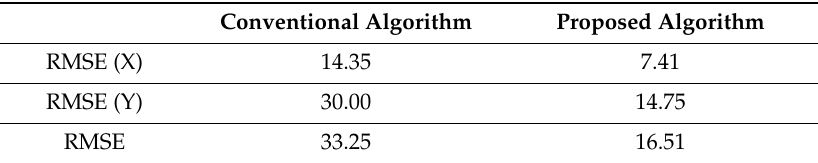
Figure 13. Results of the vehicle trajectory extraction corresponding to the di ff erent algorithms: ( a ) driving straight (up and down); ( b ) driving straight (left and right); ( c ) right turn; and ( d ) left turn. Table 3. Root mean squared error (RMSE) of vehicle trajectories corresponding to the di ff erent vehicle detection